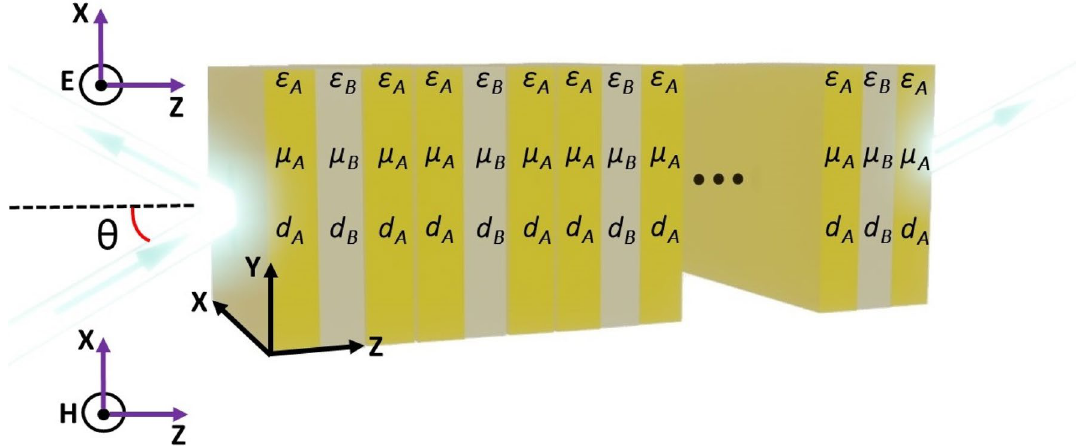
Figure 1. Schematic representation of a third-order F-1D PhC made up of BDS material and dielectric materials shown by alphabets A and B ,